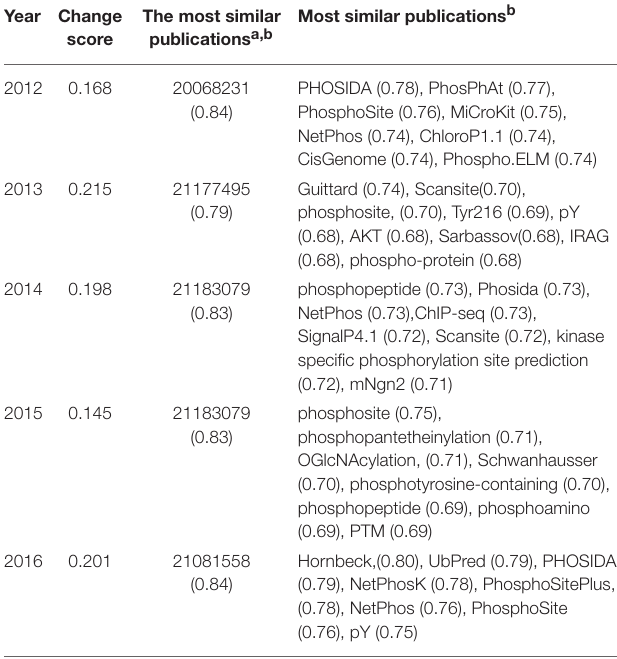
TABLE 5 | The changes of citation contexts of Olsen et al. (2006). Year Change